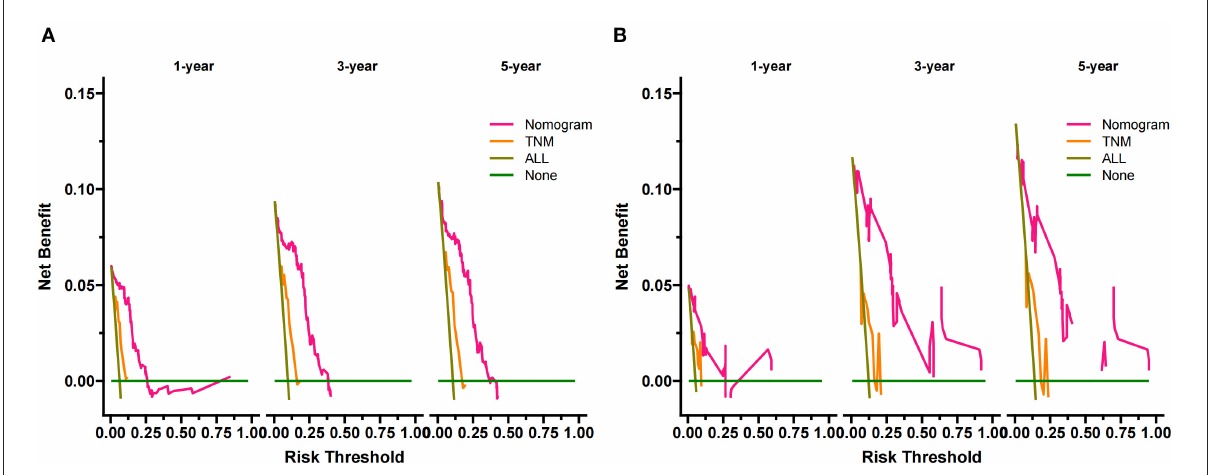
FIGURE5 DCA of the nomogram in the training set (A) and the validation set (B) . The Y-axis represents a net benefit, and the X-axis represents threshold probability. The green line means no patients died, and the dark green line means all patients died. When the threshold probability is between 0 and 60%, the net benefit of the model exceeds all deaths or none.